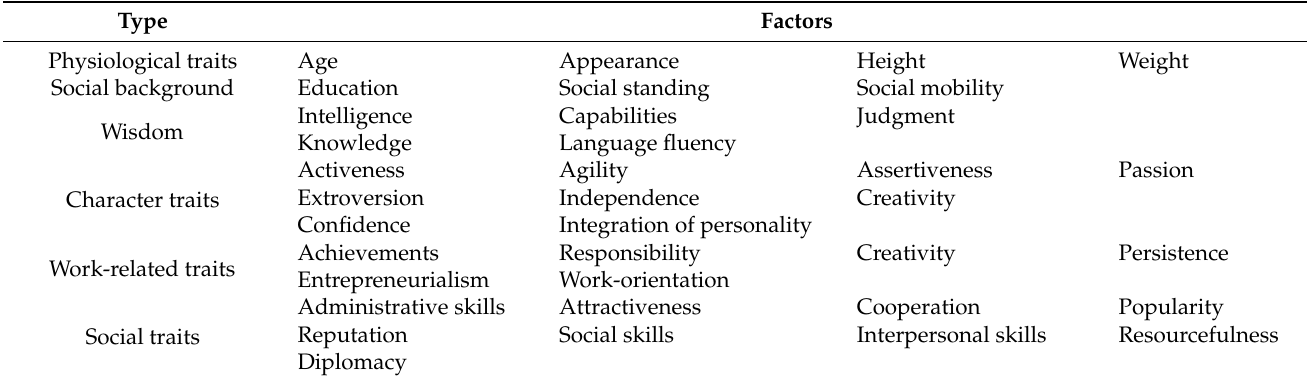
Table 3. Senior executive traits.